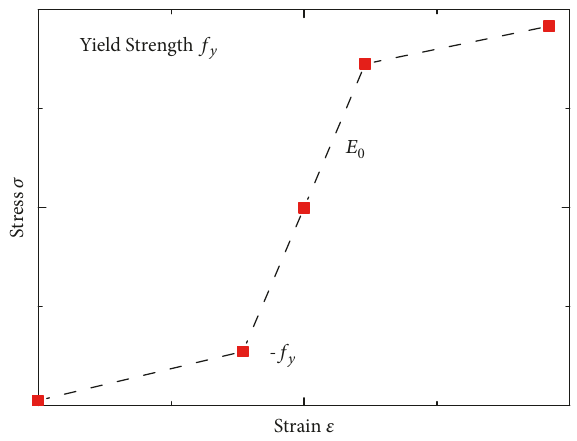
Figure 8: Bilinear reinforcement model of reinforcing steel bar. Table 2: Chloride ion concentration 𝑀 󸀠 𝑠 on the concrete surface and 0.1km from the coast.